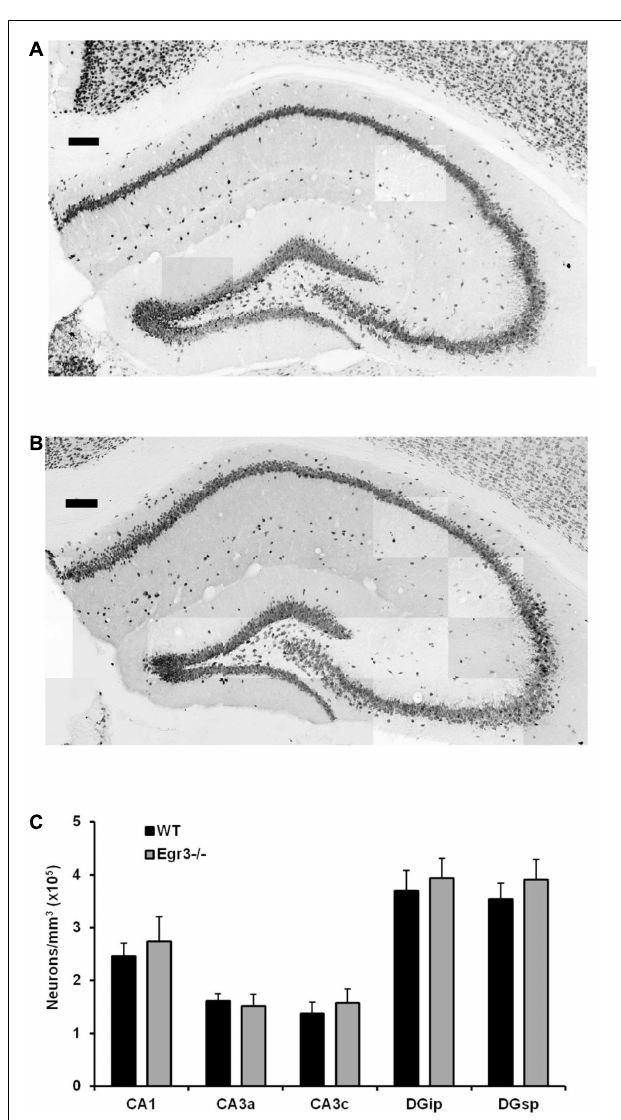
FIGURE 5 | Egr3 is not required for development of normal numbers of hippocampal neurons. Sample montaged photomicrographs from the hippocampus of anti-NeuN stained (A) WT and (B) Egr3 –/– mice show no obvious signs of changes in gross morphology (scale bar = 100 µ m). Consistent with this observation, (C) quantification of NeuN+ cells ( n = 6 animals/genotype) demonstrated no significant differences in neuron density in any hippocampal region between WT (black) and Egr3 –/– (gray)